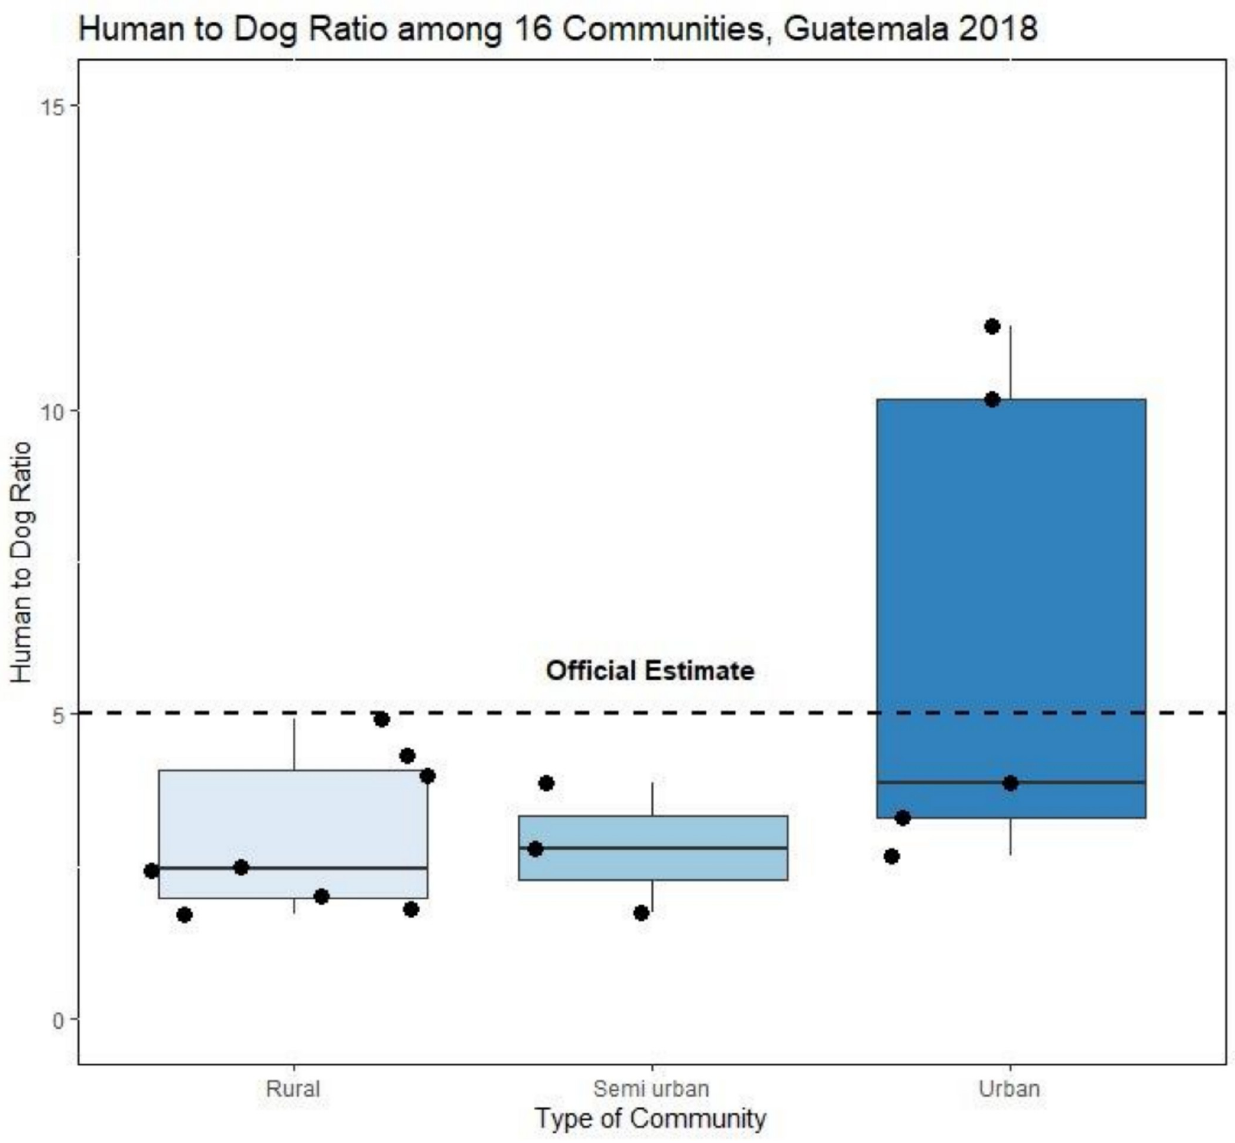
Fig 3. Distribution of the Human:Dog ratio in the different types of surveilled communities in this study, and their comparison with the official 5:1 Guatemala Human:Dog Ratio.